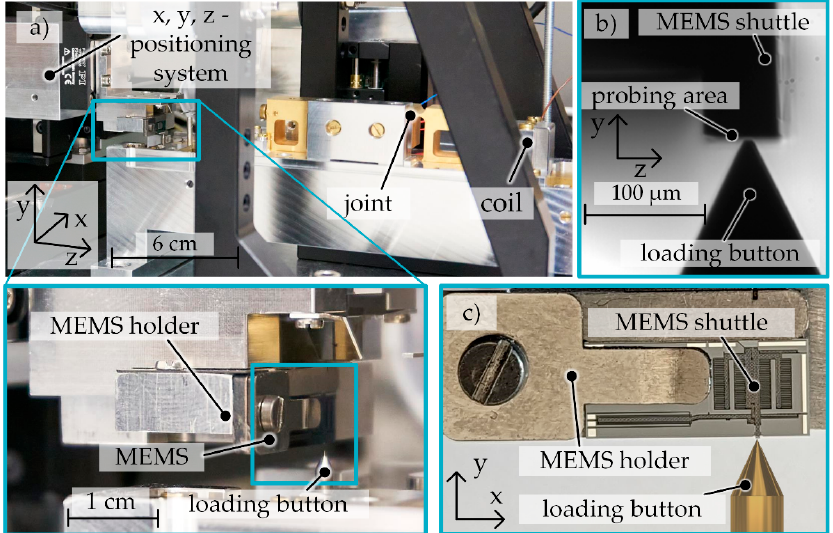
Figure 7. Force-displacement measurement device used for the stiffness measurement of the MEMS based weighing cell ( a ) overall with a magnification to the MEMS holder and the loading button; ( b ) side view from the camera used for positioning ( c ) front view with the MEMS;.